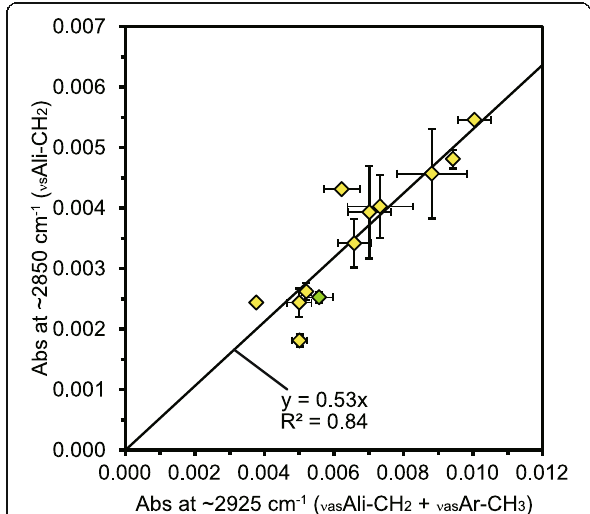
Fig. 5 Relationship between the intensities of the carbonaceous clots at ~ 2925 cm − 1 and ~ 2850 cm − 1 . The ~ 2925 cm − 1 band is due to asymmetric stretching vibrations of the aliphatic CH 2 and aromatic CH 3 , and the ~ 2850 cm − 1 band is due to symmetric stretching vibration of the aliphatic CH 2 . The yellow diamonds indicate the data for sample 96NP452, while the green diamond indicates that for sample T-58. The error bars indicate the standard deviations of the duplicate measurements